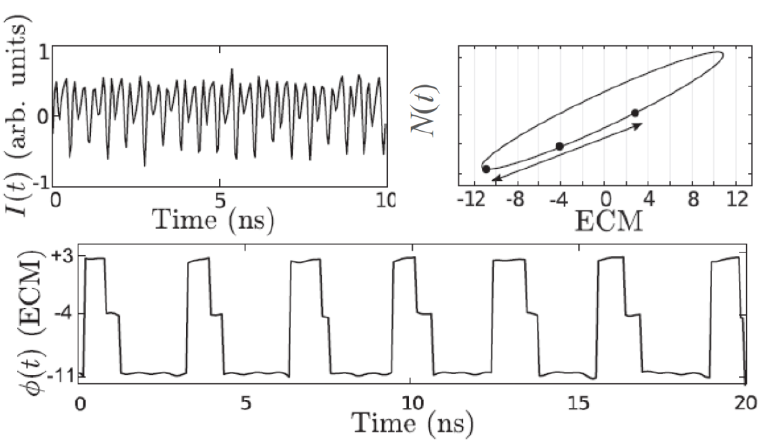
Figure 5. Period-evolution of the experimentally measured optical intensity and optical phase in the period-doubled regime (region ε of Figure 4). The top-right panel gives a visual representation of the ECMs involved. From Ref. [16].